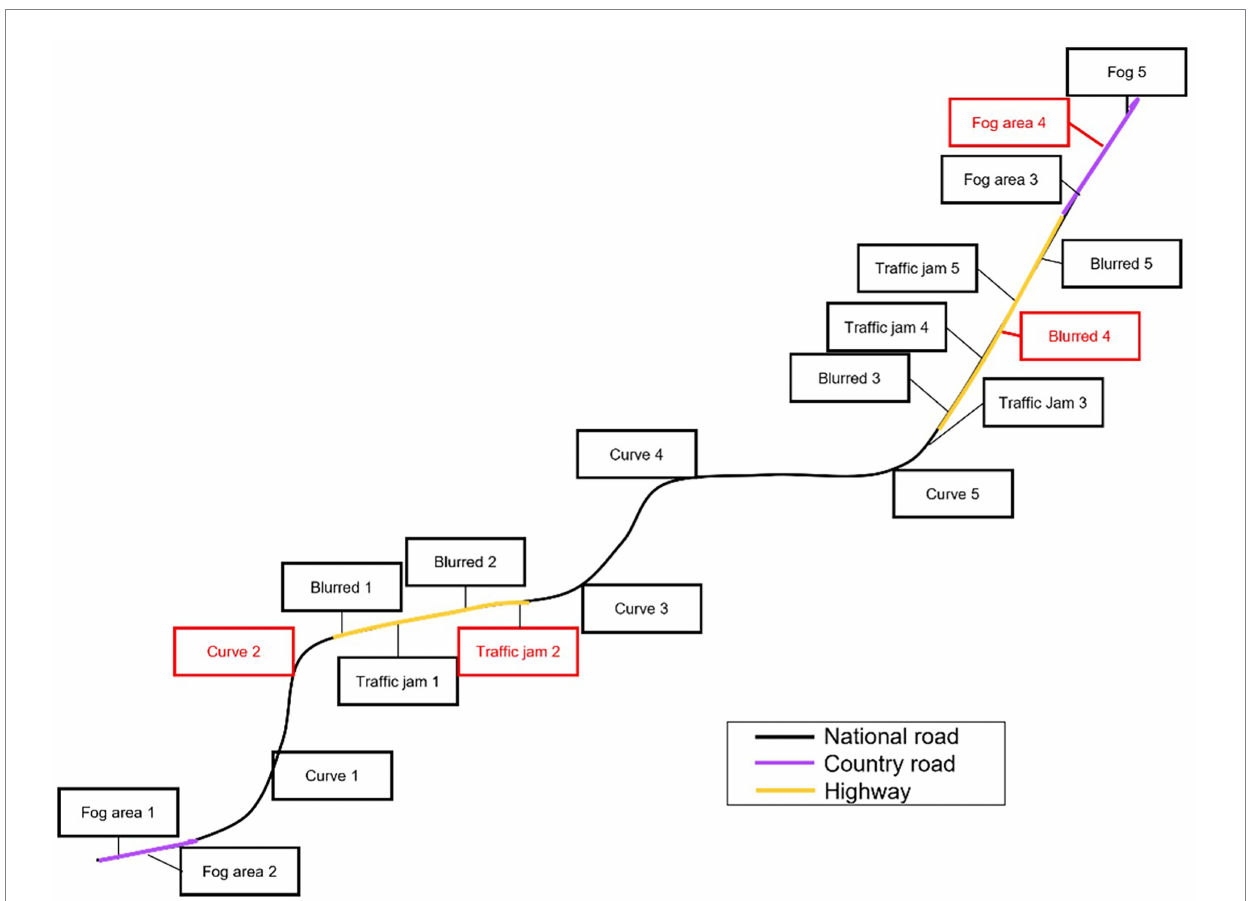
FIGURE 3 Representation of the driving scenario with the type of road and the type of event. Events marked in black did not affect driving automation systems. Events marked in red suspended driving automation